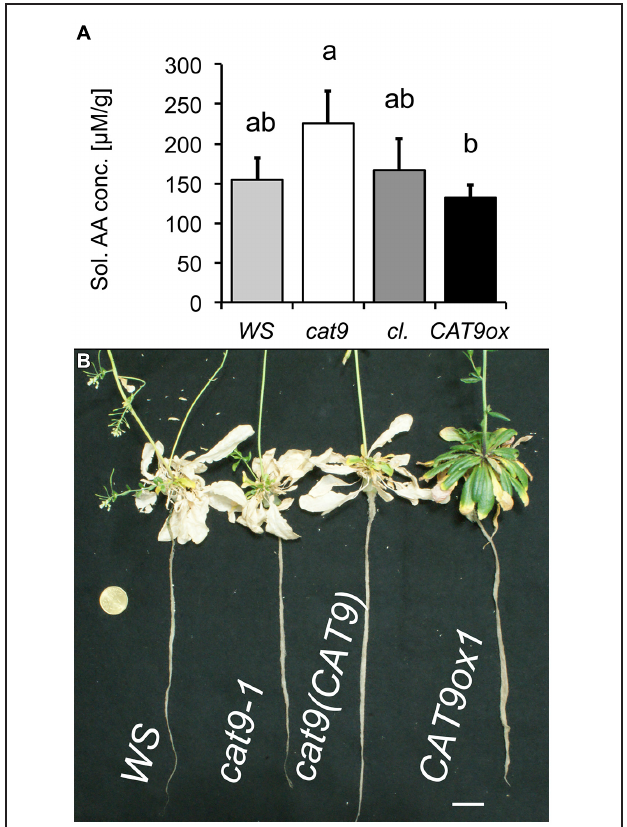
FIGURE 7 | Nitrogen starvation phenotype of mutant lines. (A) Total soluble amino acid concentration in leaves of plants initially grown for 6 weeks with 1 mM NH 4 NO 3 and then N-starved for 2 weeks. Bar colors: WS wild type (light gray), cat9-1 (white), cl (dark gray), and CAT9ox1 (black). (B) Visual phenotype of mutant plants from the above experiment, but starved for 2 further weeks of nitrogen (4 week N-starvation). Scaling bar: 2 cm. Statistically different means ( n = 5) at p < 0.05 are given with different